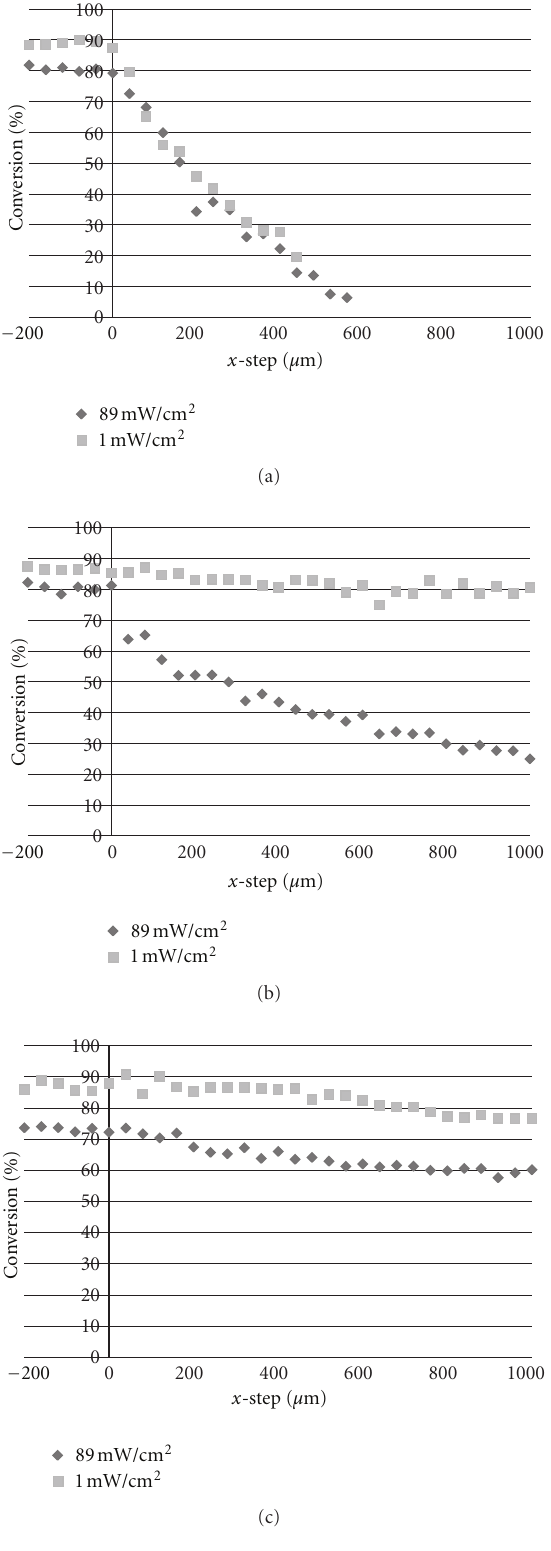
Figure 5: The e ff ect of the incident light intensity on the conversion profiles ( x -direction) observed for three di ff erent dye/amine sys- tems: (a) BP/MDEA, (b) FL/MDEA, (c) EYss/MDEA. Light source: a 150 W xenon lamp, irradiation time: 15 minutes.